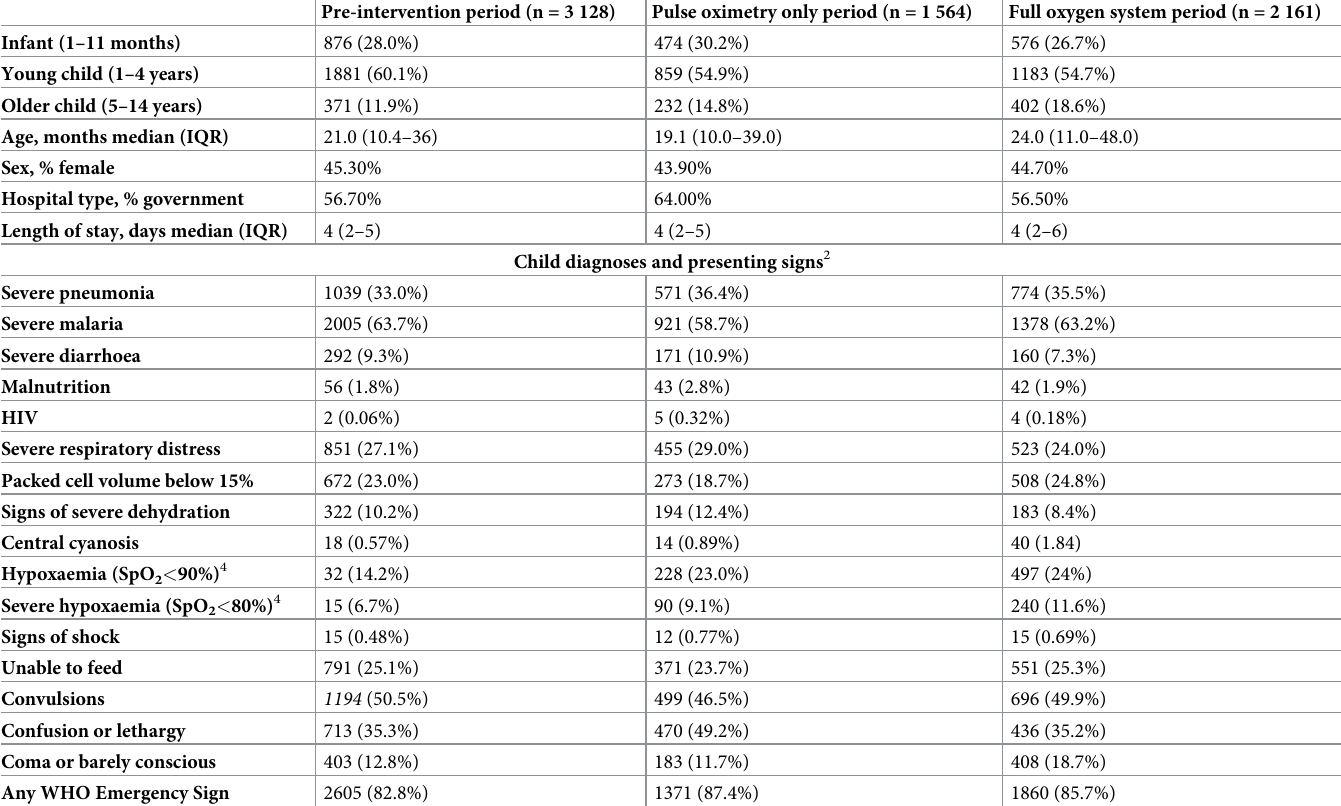
Table 1. Population characteristics of participants, by study